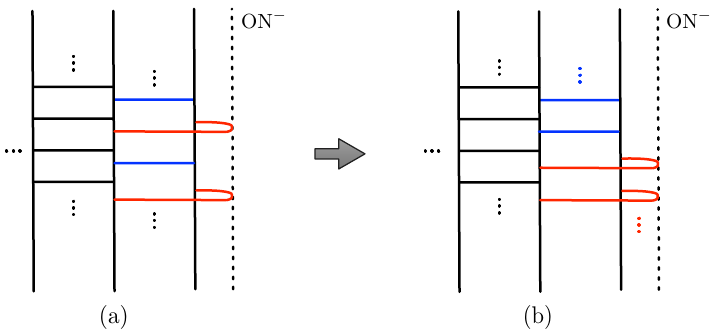
Figure 10 . Two phases of 5-brane webs with an ON-plane: (a) Overlapping phase of two bivalent SU gauge groups of a D -type quiver (b) Split phase of SU gauge groups of a D -type quiver. D5- branes in red and D5-branes in blue correspond to each SU gauge theory of two ends of bivalent